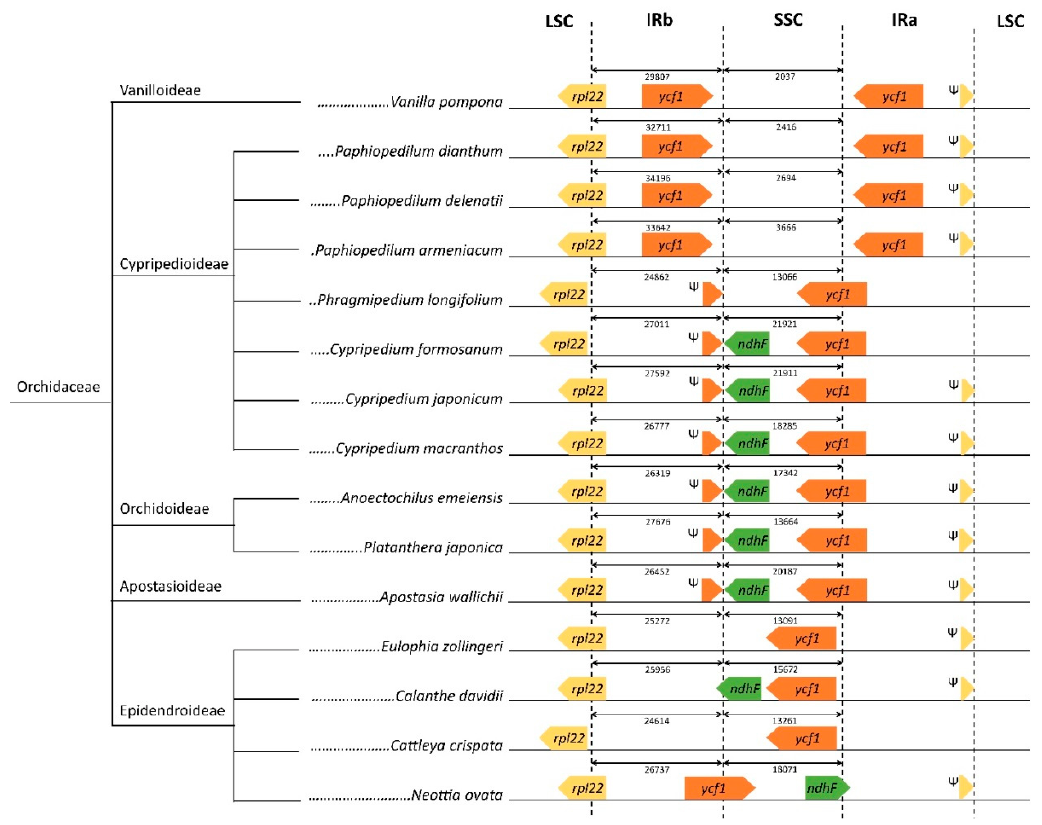
Figure 2. Schematic representation of the borders between inverted repeats (IRs) and large single-copy (LSC) and small single-copy (SSC) of P. delenatii and other 15 species from all five subfamilies of Orchidaceae. Ψ indicates a pseudogene.